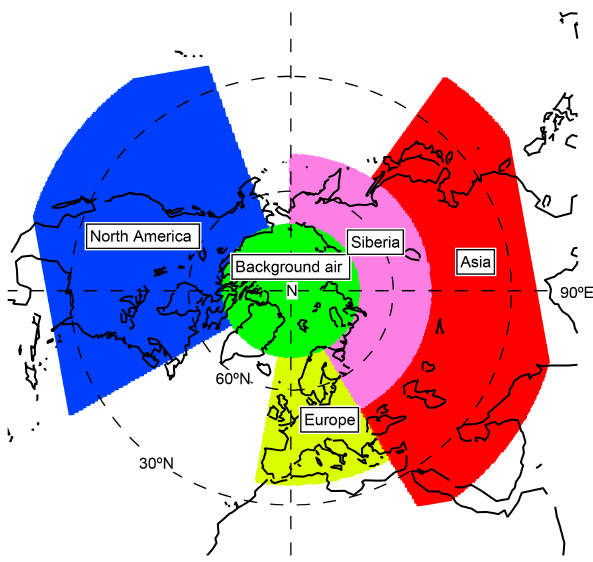
Figure 3. Source regions defined in this